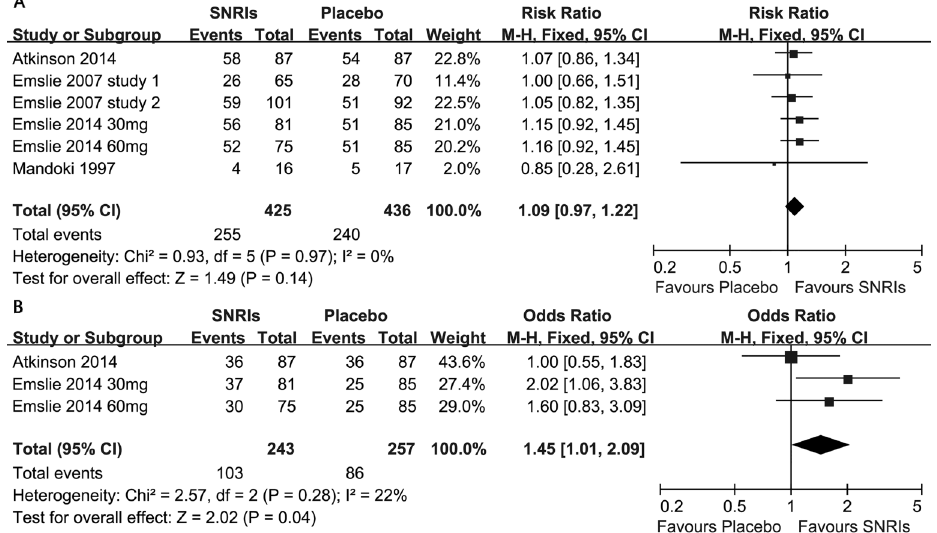
Figure 2. Primary outcome and secondary outcome: serotonin-norepinephrine reuptake inhibitor (SNRIs) vs placebo paradigms. A , comparison of SNRIs vs placebo for the primary outcome (response at end of treatment). B , comparison of SNRIs vs placebo for the secondary outcome (remission at end of treatment). See Table 1 for details of